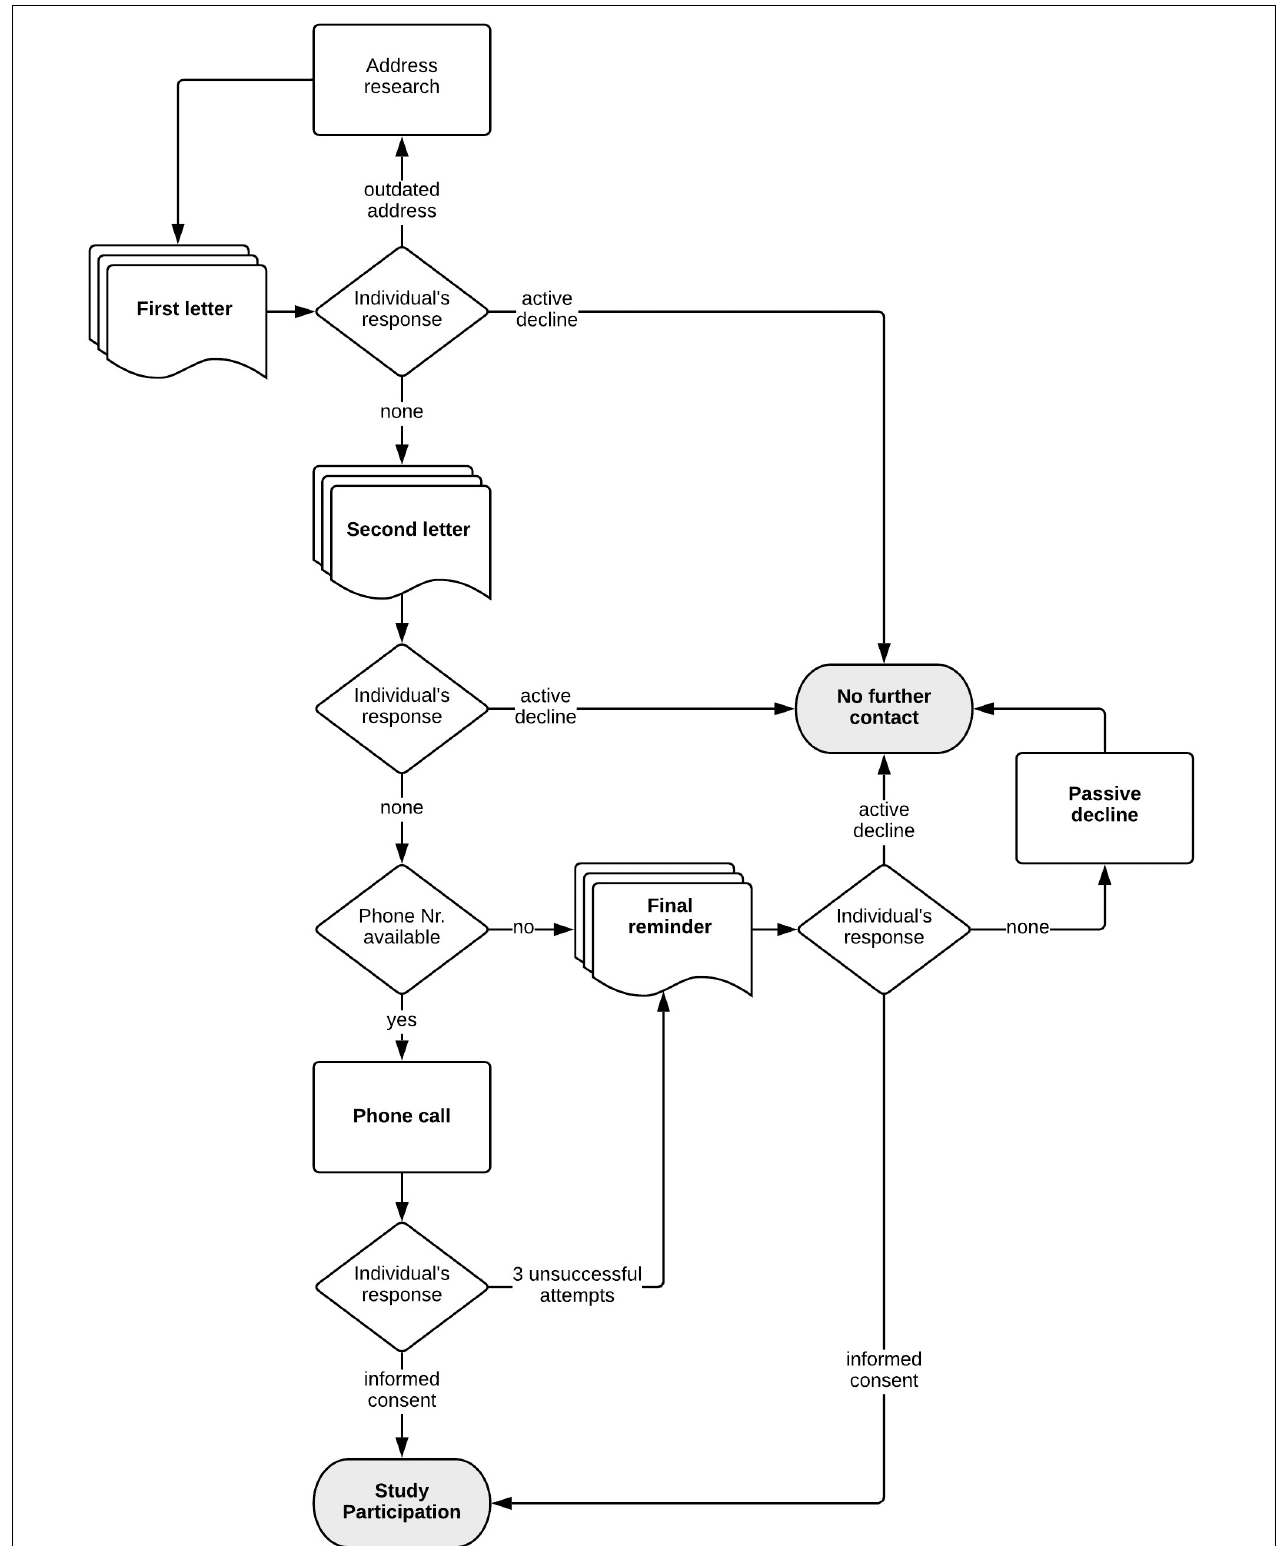
FIGURE 6 | Recruitment